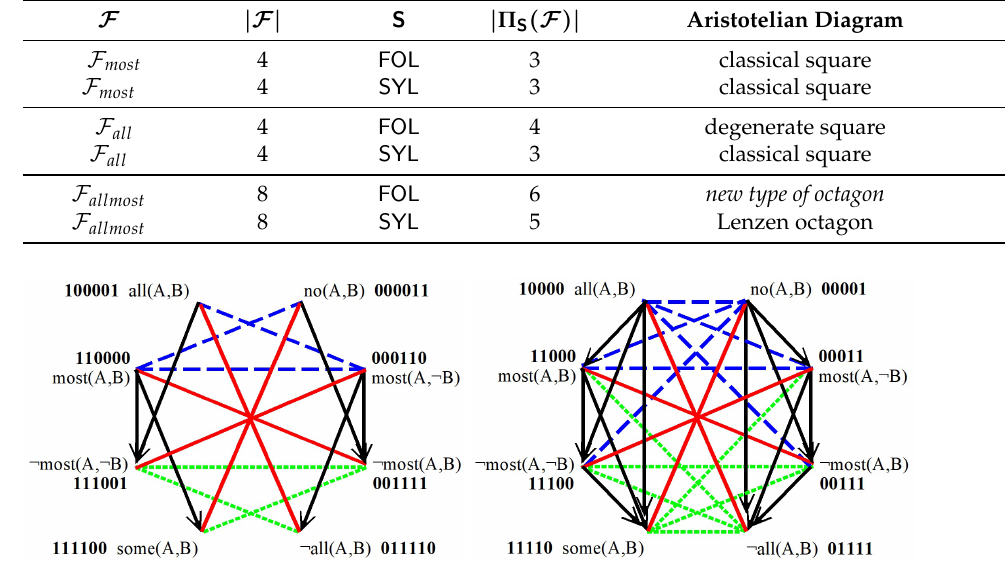
Figure 10. Octagons with bitstrings of length 6 and length 5 for F allmost , relative to resp. FOL and SYL